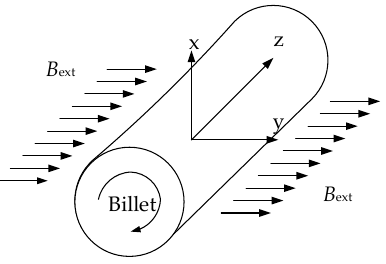
Figure 2. Principle diagram of the novel DC induction heating technique. B ext denotes the external DC magnetic field generated by the DC current in the windings.